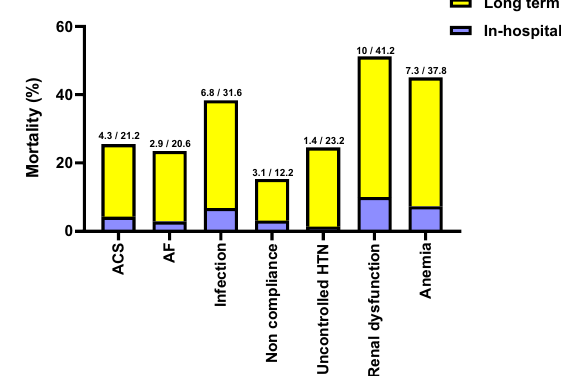
Fig. 2 In-hospital and long-term mortality rates for each precipitating factor are represented above each column. ACS coronary syndrome; AF Atrial fibrillation; and HTN =